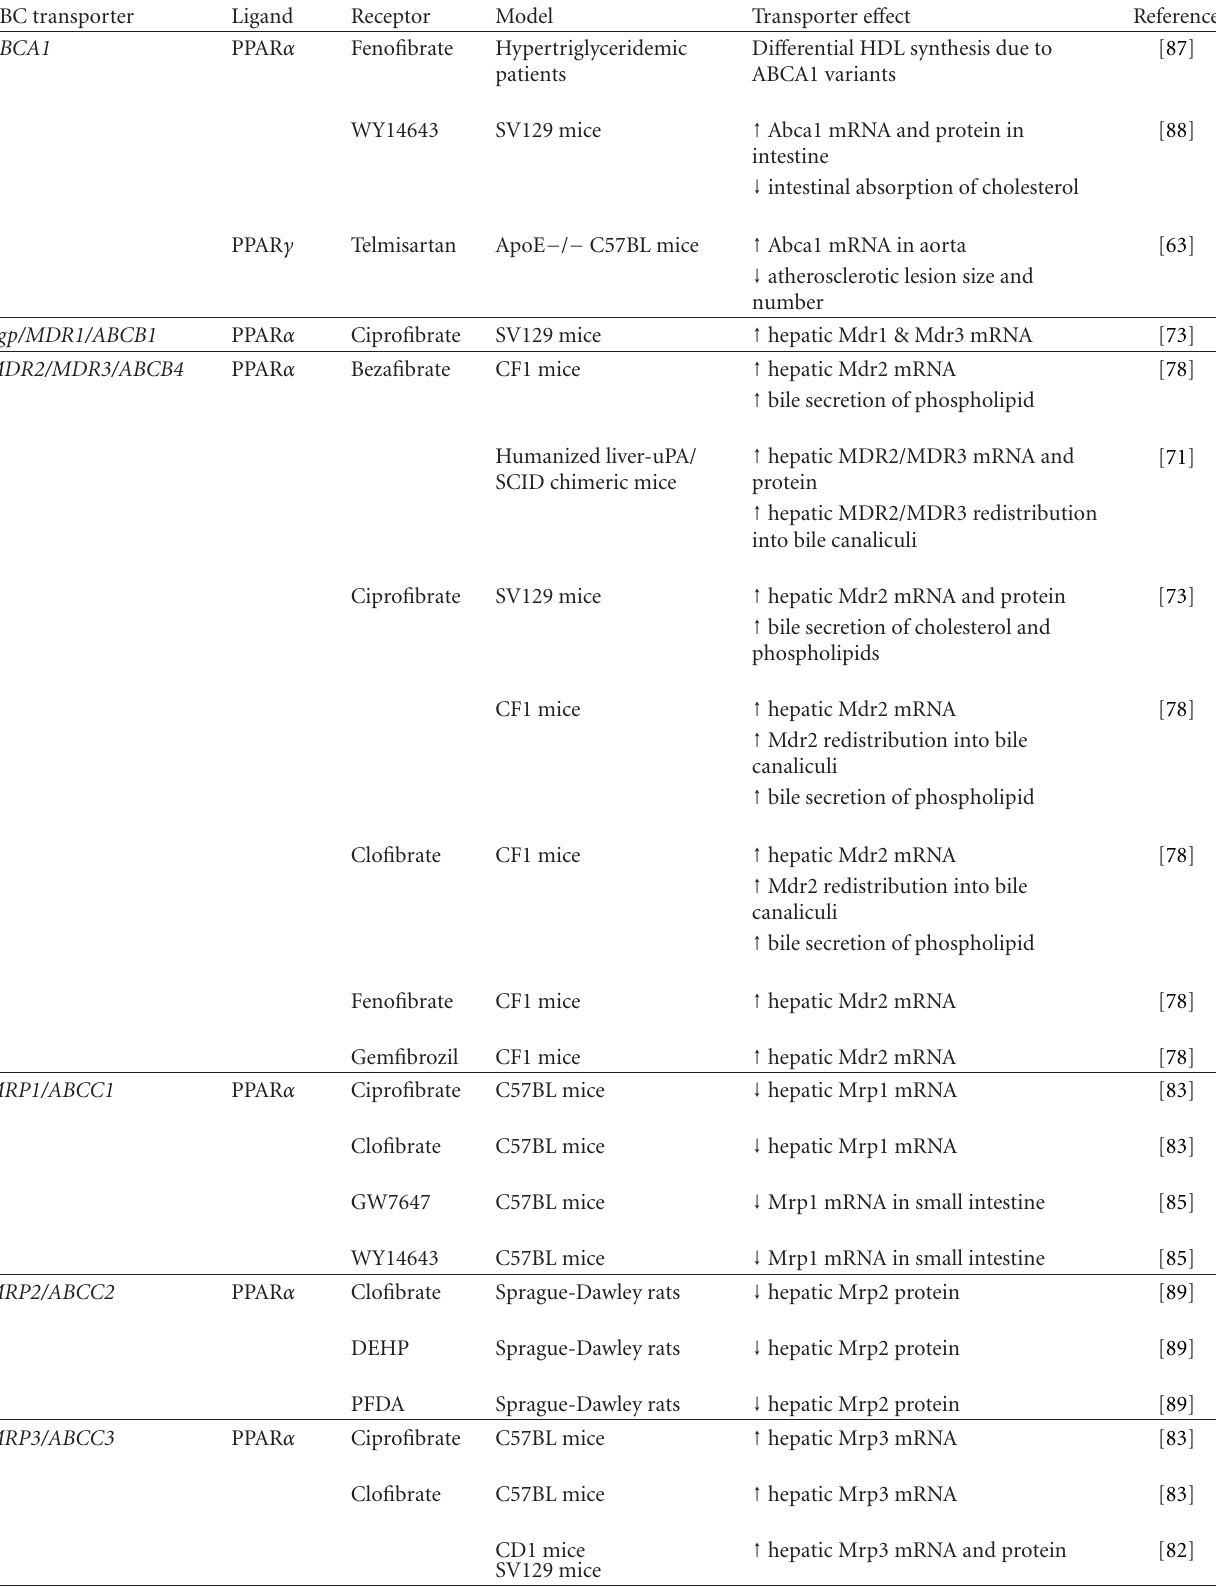
Table 2: In vivo e ff ects of PPAR ligands on ABC